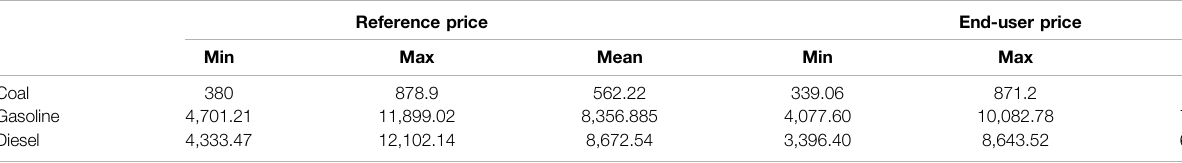
TABLE 4 | The benchmark price and end-user price over 2004 – 2015 (Yuan/Ton).